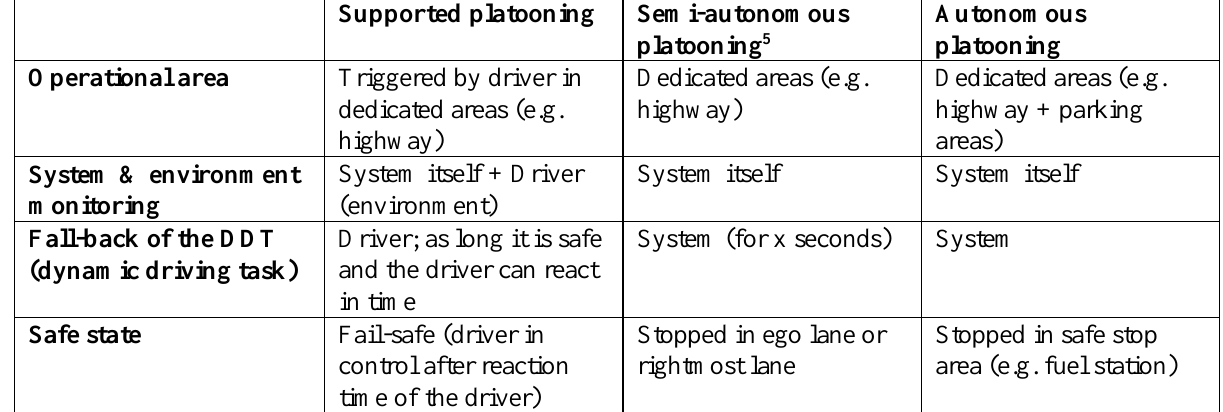
Table 1. Some differences in the ODD of different platooning levels (example adapted from ENSEMBLE (Vissers et al. 2018; Dehlia Willemsen et al. 2020)) Supported